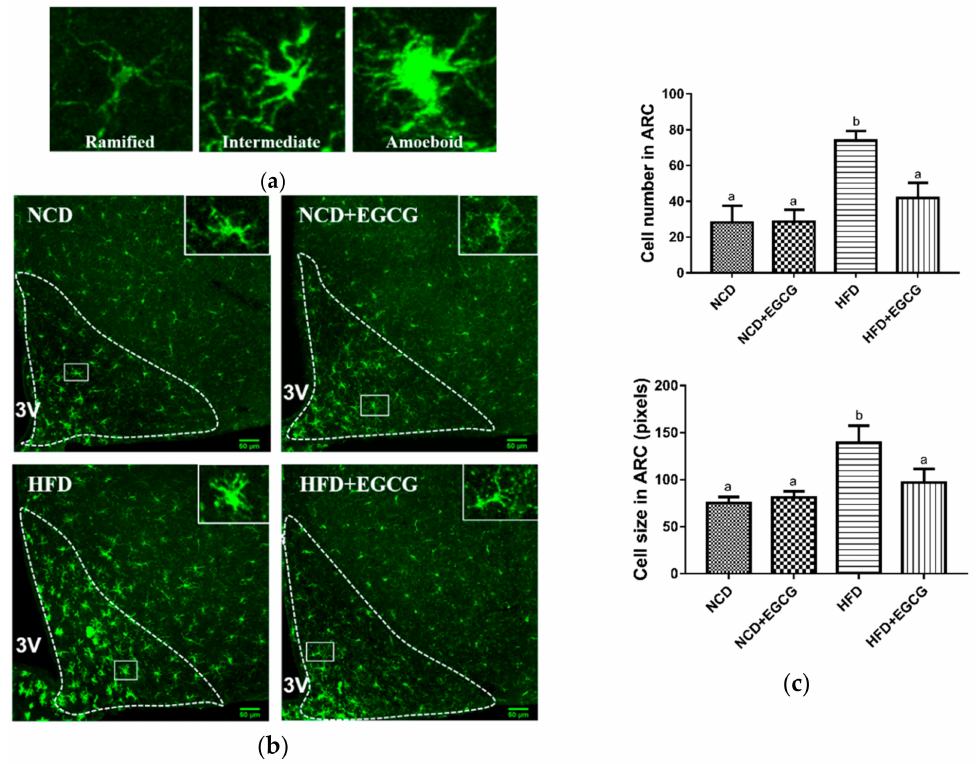
Figure 4. Effect of EGCG on microglia activation in hypothalamic arcuate nucleus (ARC). ( a ) Representative micrographs of three different morphological phenotypes of microglia: ramified, intermediate, and amoeboid in hypothalamus area; ( b ) Representative micrographs of immunofluorescence labeling for Iba1 in hypothalamic ARC (outlined by white dashed lines) and higher magnification insets (outlined by white solid lines) ( c ) Quantification of cell number and cell size of positive Iba-1 cells in hypothalamic ARC. Data are shown as mean ± SD ( n = 3). Mean values with different letters (a and b) are significantly different ( p <